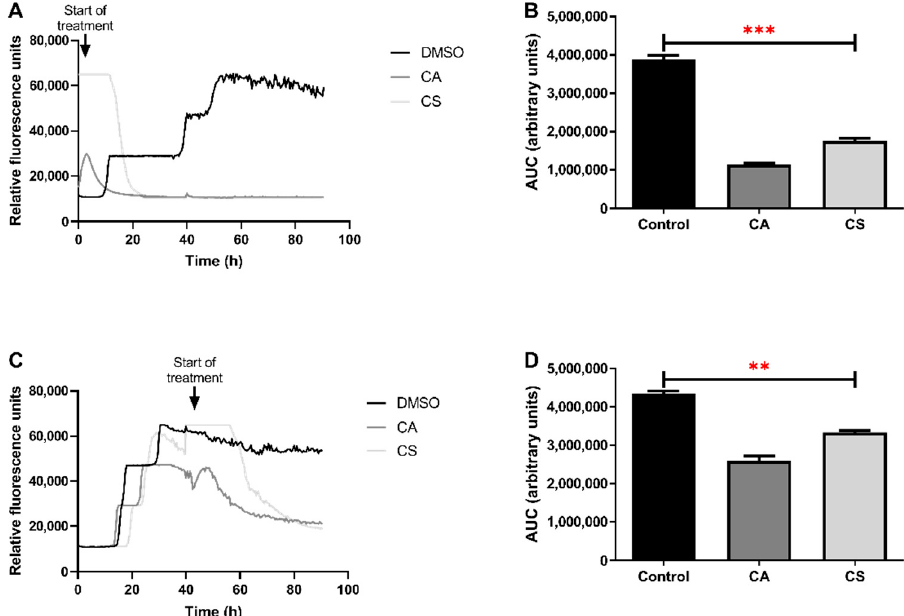
Figure 5. RT-QuIC assays. Aggregation of recPrPC in RT-QuIC assays using CSF from four different sCJD patients as a seed was evaluated in the presence or absence of CA and CS (1 mM final concen- tration). ( A ) CA and CS were added to the reactions from the beginning, and the Th-T fluorescence was recorded every 30 min. In control reactions containing only DMSO, the solvent vehicle for the compounds, PrP Sc aggregates are formed, whereas CA and CS block their formation. ( B ) AUC values, estimating Th-T fluorescence (and thus aggregation) of each reaction were computed, and the statistical significance was estimated by T -test. The addition of CA led to a reduction of protein aggregation by ~71%, whereas CS-induced reduction was ~55%. ( C ) RT-QuIC assays were started without the addition of the compounds, and Th-T fluorescence reached a plateau, indicating conversion and aggregation of PrP Sc . The addition of CA and CS to the reaction mixture led to a pronounced decline in Th-T fluorescence. ( D ) AUC values were estimated for the reactions and a statistically significant reaction of the protein aggregation by ~40% for CA and ~23% for CS was observed. Graphs ( A , B ) depict data from reactions using CSF from four different sCJD patients as a seed (each reaction performed in triplicates). Columns in ( B , D ) represent means ± SD of the AUC calculated for the individual fluorescence curves of each replicate reaction; stars denote statistical significance (unpaired, one-tailed, T -test); **: p value < 0.01, ***: p value < 0.001. CA: dark grey, CS: light grey, Control: